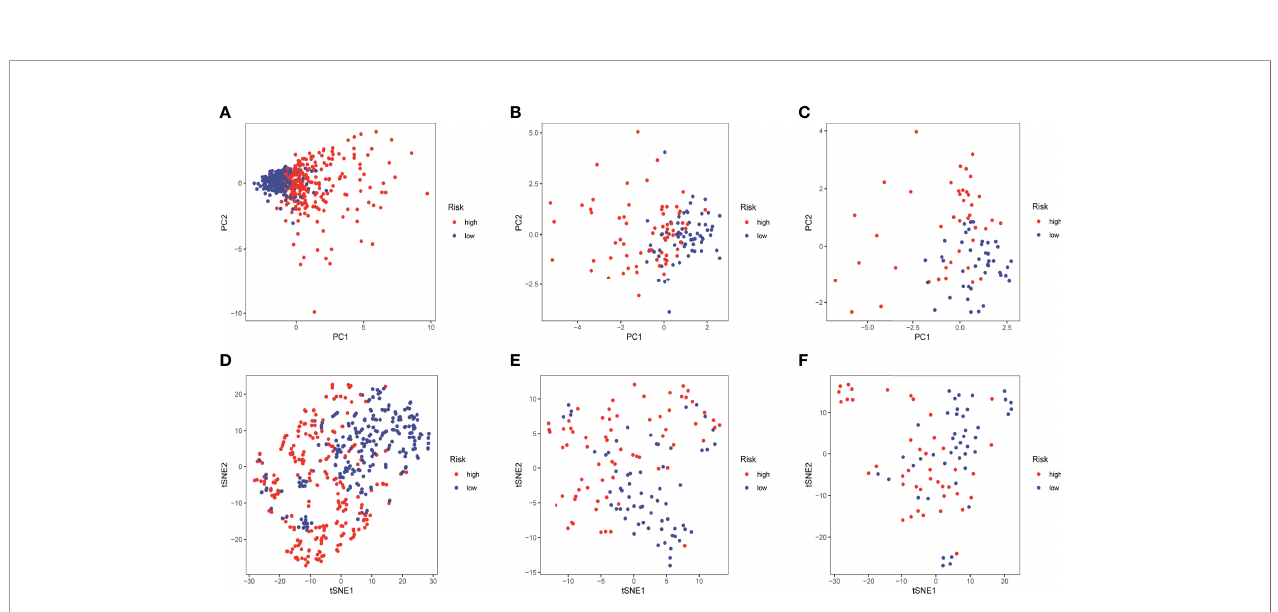
FIGURE 5 | Quality of data control by PCA and tNSE analysis. (A – D) TCGA LUAD. (B – E) GSE42127. (C – F)